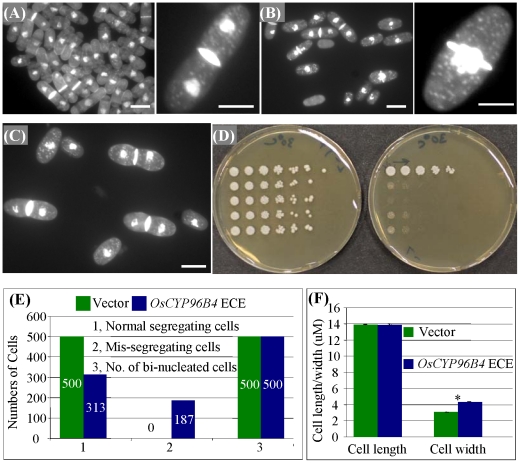
Heterologous ectopic-expression of OsCYP96B4 in S. pombe.(A) A group of S. pombe cells expressing the vector control (left) and a magnified view of single vector control cell (right). (B) A group of cells showing ectopic expression of OsCYP96B4 in the yeast cells with chromosome segregation defect (left) and a magnified view of ‘cut’ phenotype. (C) The yeast cells ectopically expressing OsCYP96B4 show dumbbell shape. (D) Over-expression of OsCYP96B4 in the yeast is toxic to its cells. The left shows the control and the right is the overexpressor. (E) The effects of ectopic expression of OsCYP96B4 in the yeast on cell segregation. (F) An investigation of cell length and width of the S. pombe cells upon ectopic-expression of OsCYP96B4. Bars in (A) to (C) = 5 μm. The asterisk in (F) indicates the significant difference between the control and ectopic expression of OsCYP96B4 in yeast at P<0.05 by t-test.